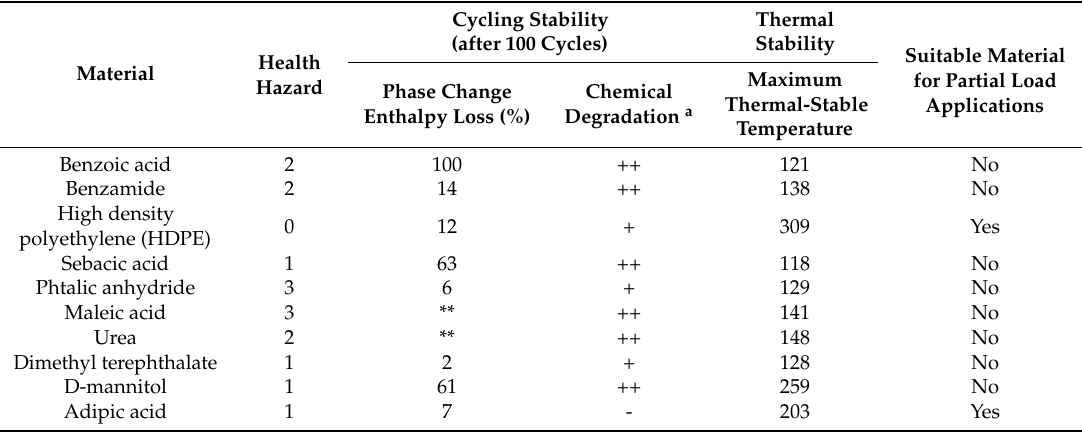
Table 5. Summary of the characterization of the sixteen PCMs under